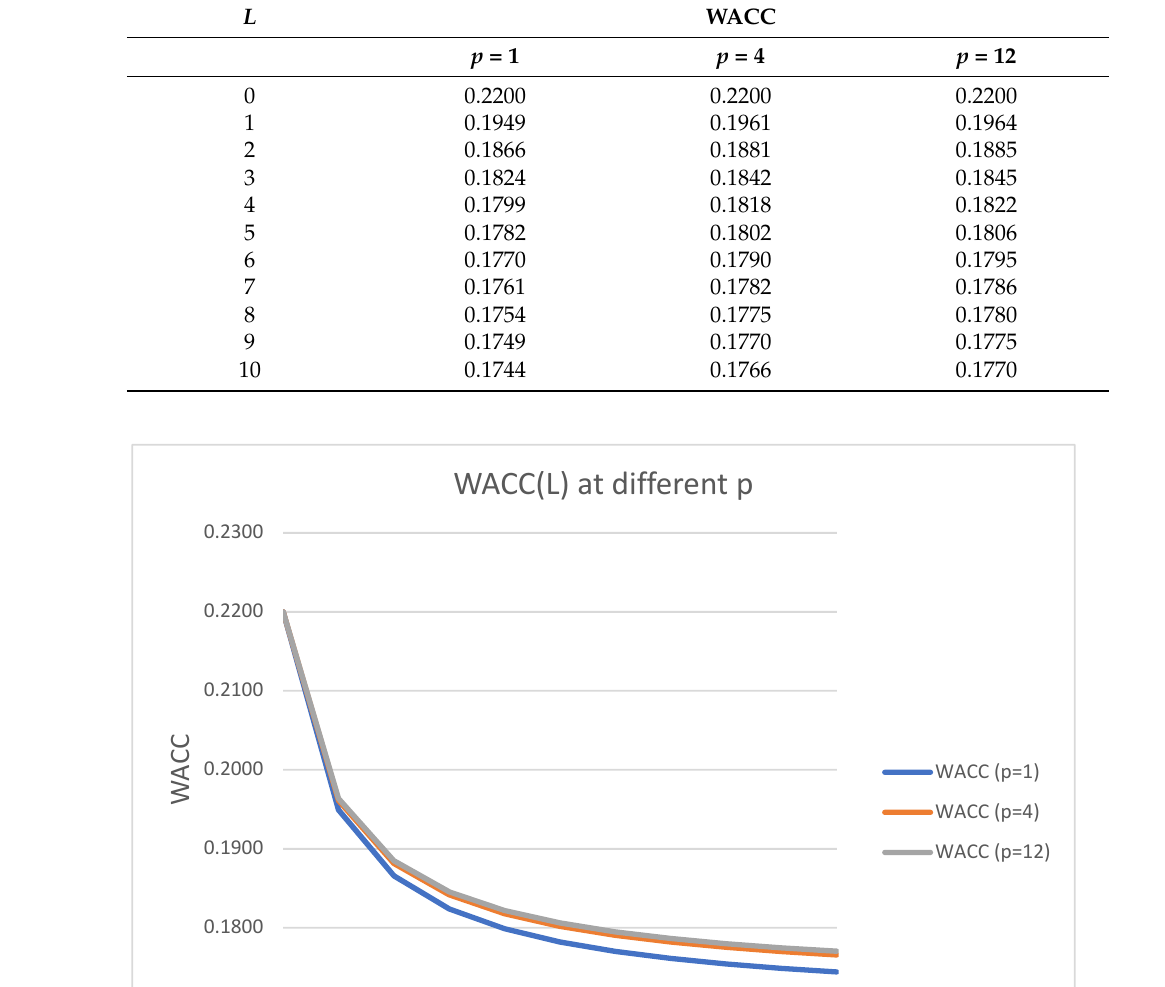
Table 1. Change of weighted average cost of capital, WACC, with leverage, L , for k d = 0.14, k 0 = 0.22, and p = 1, 4, and 12.